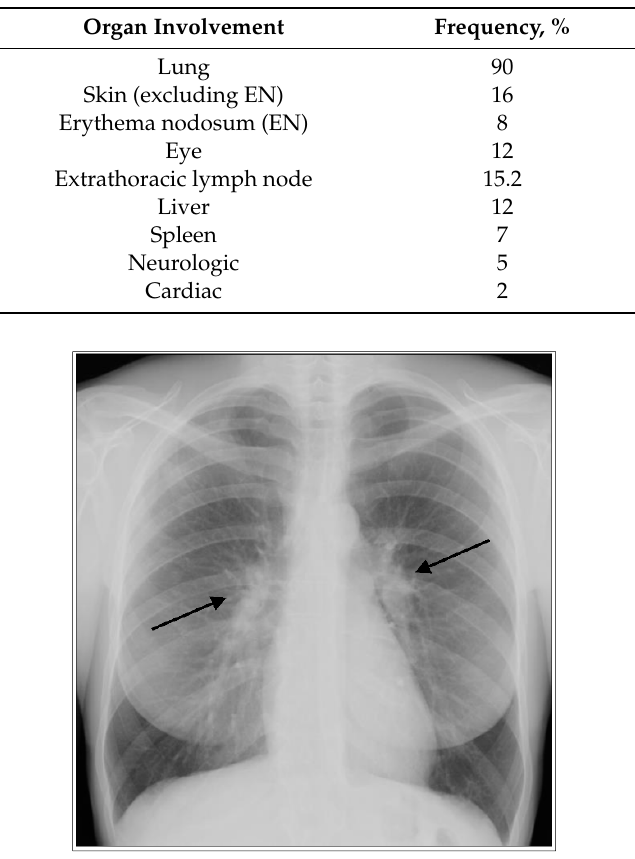
Figure 1. Acute form of sarcoidosis. Posterior-anterior chest radiograph of a 35-year-old female with Löfgren’s syndrome demonstrating bilateral hilar adenopathy (arrows) without evidence of parenchymal lung involvement.